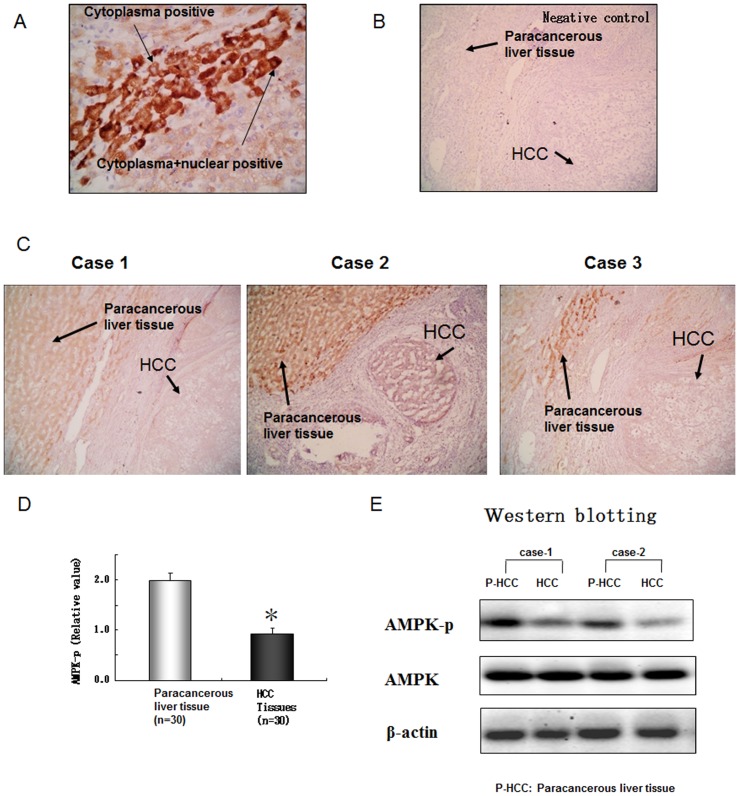
Immunohistochemistry of phosphor-AMPK showed a lower degree of AMPK activity in HCC tissues than in paracancerous liver tissues.(A) Positive signals were detected in cytoplasm and occasionally in nucleus. (B) Negative control (omitting primary antibody). (C)Representative images of three samples of HCC and paracancerous liver tissue showing AMPK activity. (D) Relative AMPK activity in 30 tissue samples. Data are mean±SD. *p<0.05 (E) Western blot analysis of phosphor-AMPK (AMPK-p) and AMPK. Representative bands from five independent experiments.